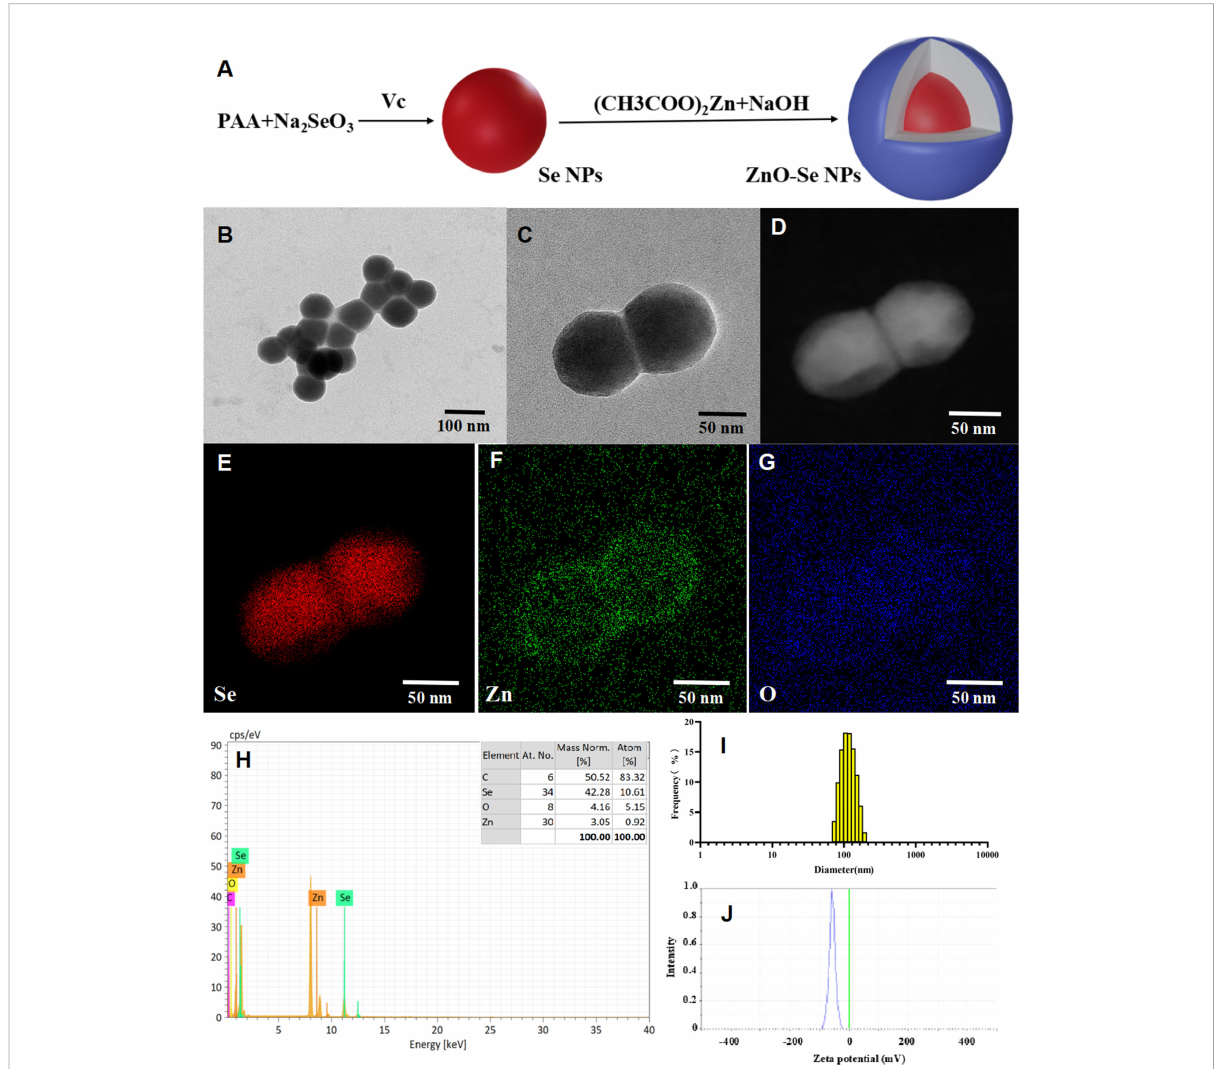
FIGURE 1 Preparation and characterization of ZnO-Se NPs. (A) Schemes for the preparation of ZnO-Se NPs. (B, C) Typical TEM images of ZnO-Se NPs. (D) Typical TEM-EDS dark fi eld image of ZnO-Se NPs. (E) Typical TEM-EDS selenium (Se) mapping analysis of ZnO-Se NPs. (F) Typical TEM-EDS znic (Zn) mapping analysis of ZnO-Se NPs. (G) Typical TEM-EDS oxygen (O) mapping analysis of ZnO-Se NPs. (H) TEM-EDS elemental analysis of ZnO-Se NPs. (I) Size analysis of ZnO-Se NPs by DLS. (J) Zeta potential analysis of ZnO-Se NPs by